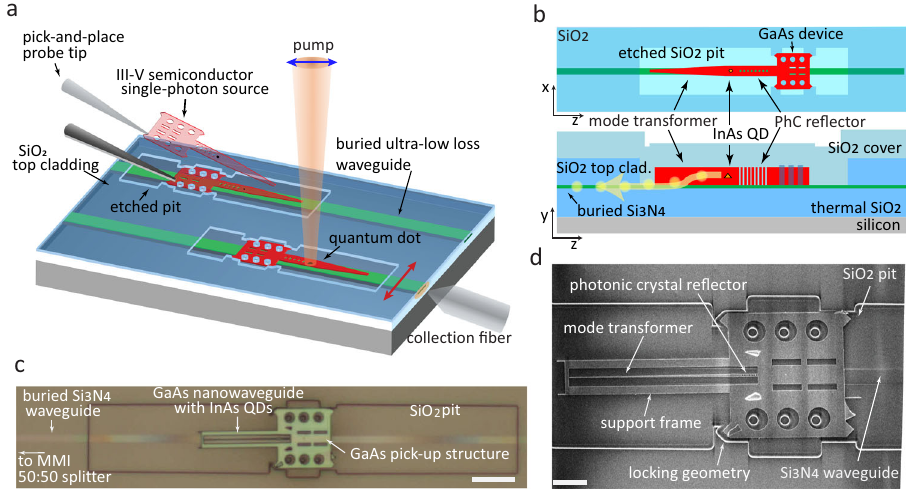
Fig. 1 | Integration of single photon source to ultra low-loss waveguide. a Schematic of pick-and-place hybrid integration of a GaAs nanophotonic device containing InAs quantum dots (QDs) onto an ultra-low loss Si 3 N 4 waveguide (ULLW). Tungsten probes were used to place and align the GaAs device to the etchedpitandtheburiedULLW.Controlofthepumpbeampolarization(indicated by the blue arrow) allows resonant QD excitation with minimal pump scattering into the ULLW, allowing observation of resonance fl uorescence coupled to the